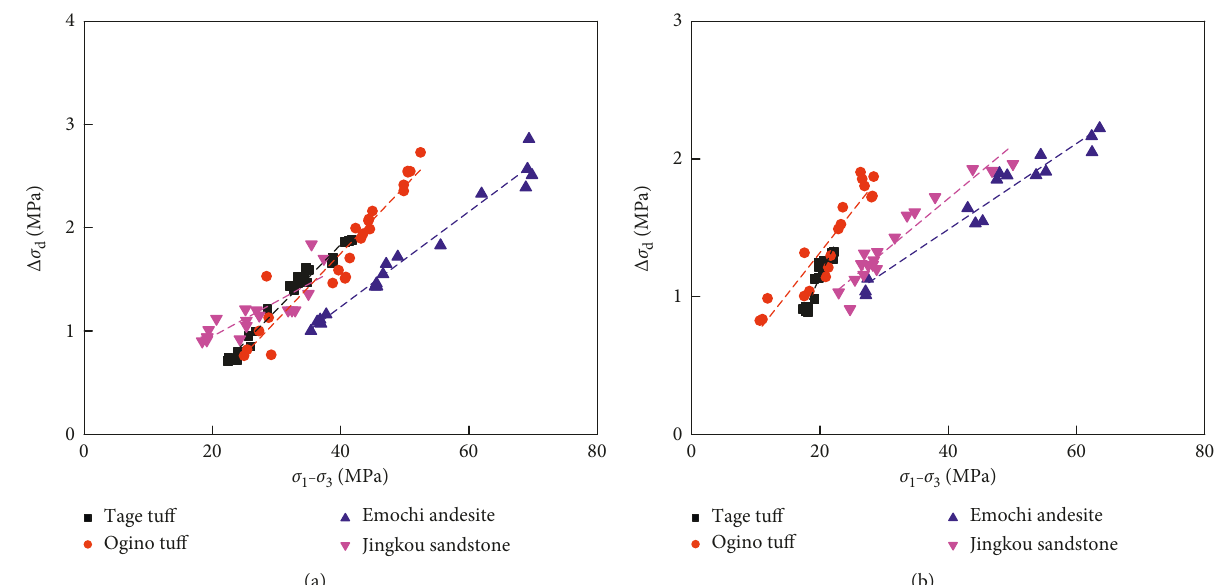
Figure 10: σ versus peak strength under (a) air-dried, (b) wet conditions. △